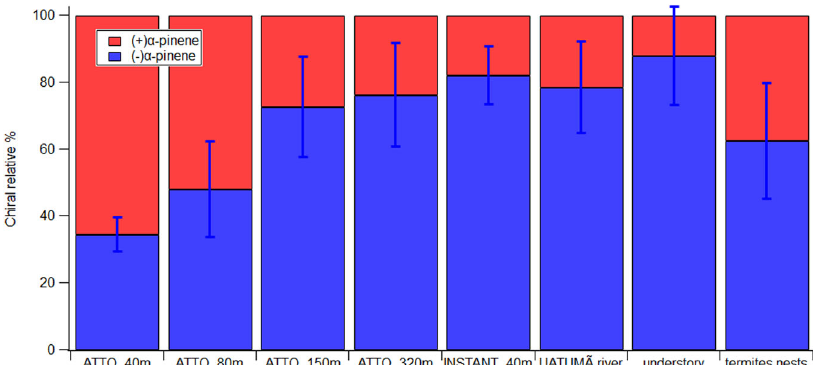
Fig. 8 Average relative abundance in percent of the ( − )- α -pinene and ( + )- α -pinene for different samples collected on or around the ATTO tower. From left to right, the number of samples represented by each bar is 64, 64, 48, 48, 10, 12, 5, 12. Error bars represent the standard deviation of the abundance for all the samples taken. The towers ATTO and INSTANT are located at (S 02° 08.7520 ’ W 59° 00.3350 ’ and S 02° 08.6470 ’ W 58° 59.9920 ’ , respectively). The Uatumã river samples were collected on a 5 km stretch of river upstream from the ATTO site. Understory samples were collected below the ATTO tower at 20 – 30 cm height from the forest fl oor. Termite nest sampling was conducted above two nests near to the ATTO site (see